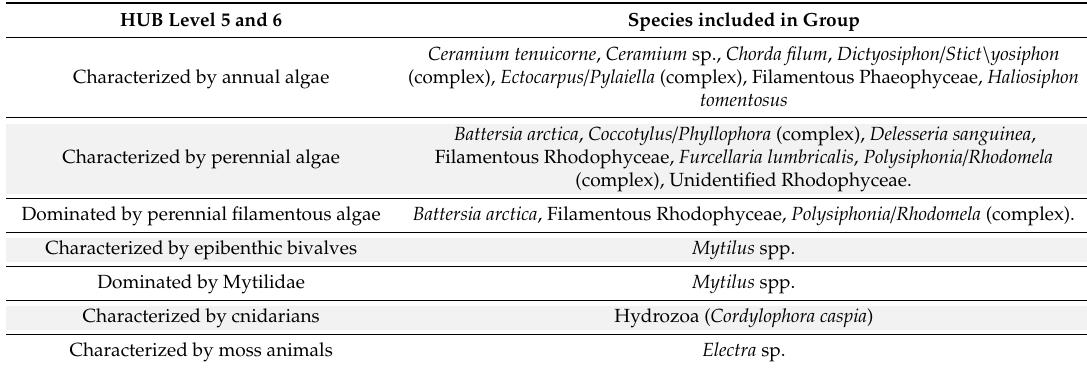
Table 4. List of HUB level 5 and 6 groups in the study area, and the species